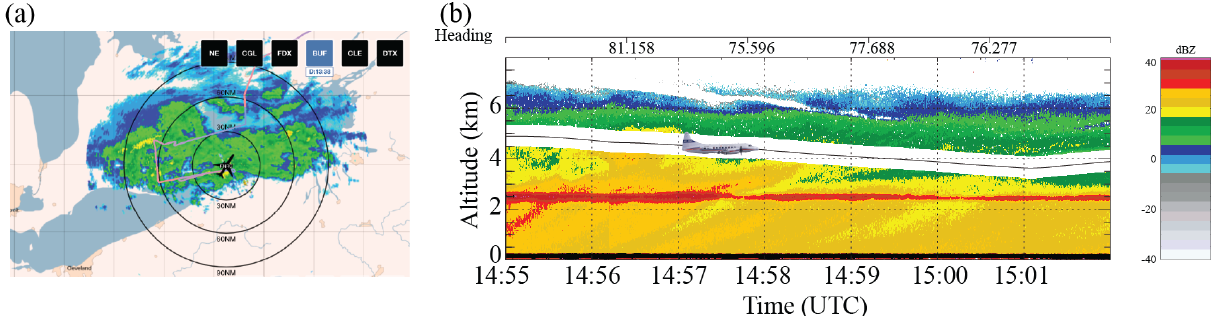
Figure 13. Same as Fig. 8 except during the PDPP data collection inside a winter storm on 25 March